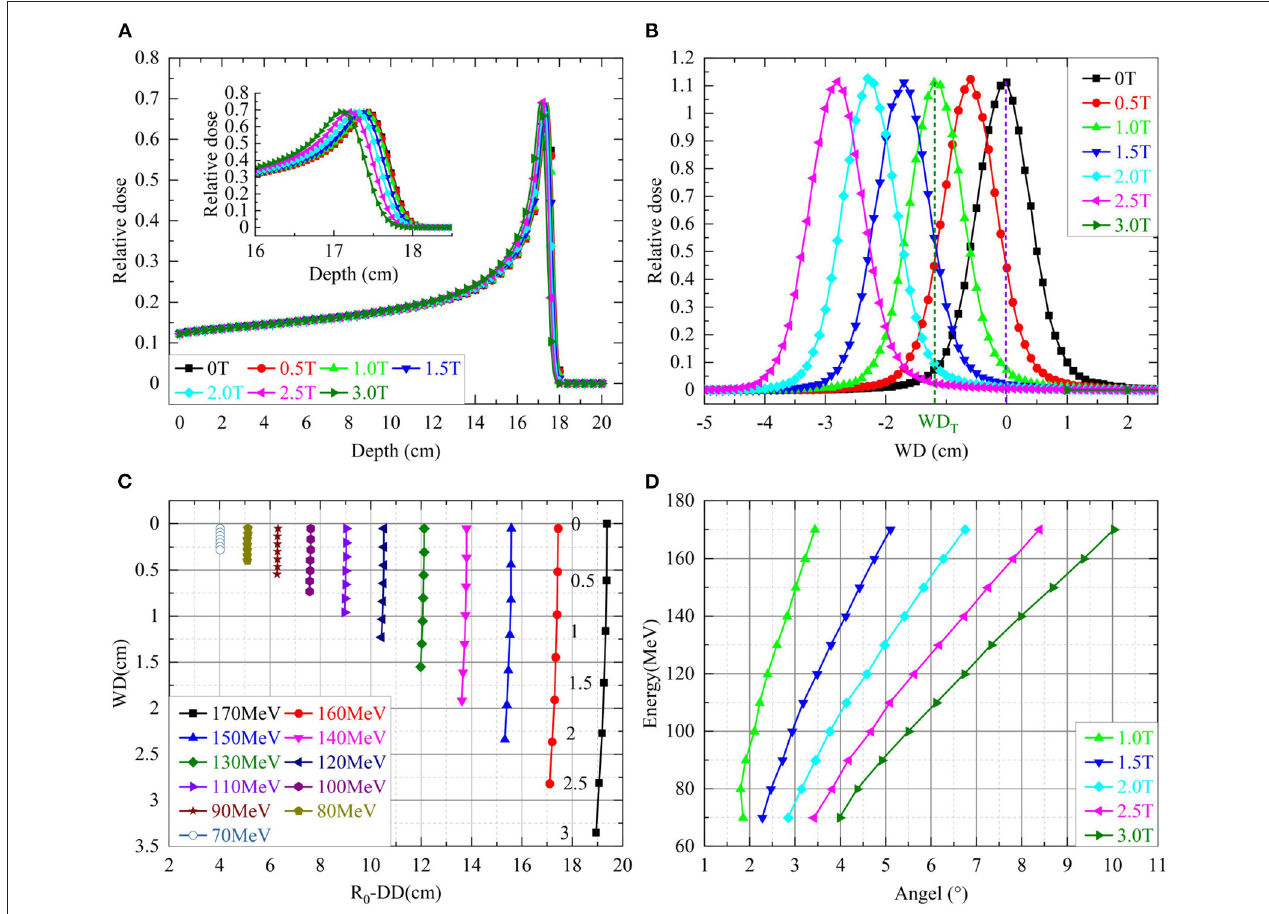
FIGURE 2 | (A) Shows the simulated depth doses of protons with 170 MeV over different field strengths. The insert shows the details of depth doses near the Bragg-peak. (B) Shows the shifts of WD for various energies with different field strengths. The numbers next to the shifts of 170 MeV indicated corresponding field strengths. (C) Shows the lateral dose profiles of protons with 170 MeV over different field strengths in the axis of WD . (D) Shows the beam deflection angles for incidence beam